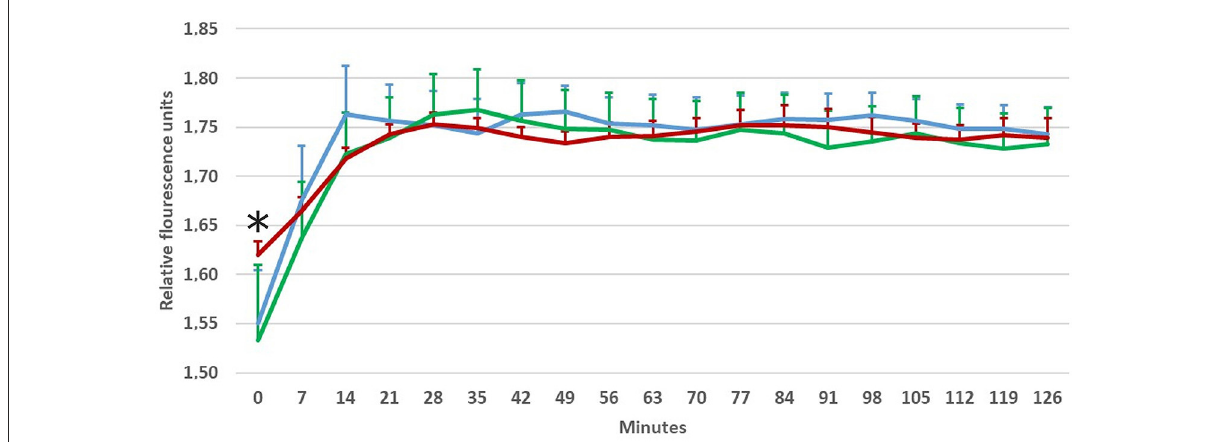
FIGURE5 Phagocytic activity of macrophages induced by Green Zymosan Bioparticle in Experiment 4a and measured using fluorescence (Ex/Em) at 485/528nm on a Cytation 1 every 7min for 2h at a temperature of 27 ◦ C. Before application of zymosan particles, cells were preincubated for 24h at test temperatures (8, 17.5, and 37 ◦ C). Red line- − 37 ◦ C, green line- − 17.5 ◦ C, blue line- − 8 ◦ C; *Initial levels of phagocytic activity (within 1min after application which corresponds to time point 0) differ significantly at 8 and 17.5 ◦ C when compared with 37 ◦ C (Fisher’s LSD, F = 5.985, p = 0.008). Average data and positive values of standard deviation (error bars) at each minute of measurement shown based on 2 replicates/5 repetitions, n = 10.